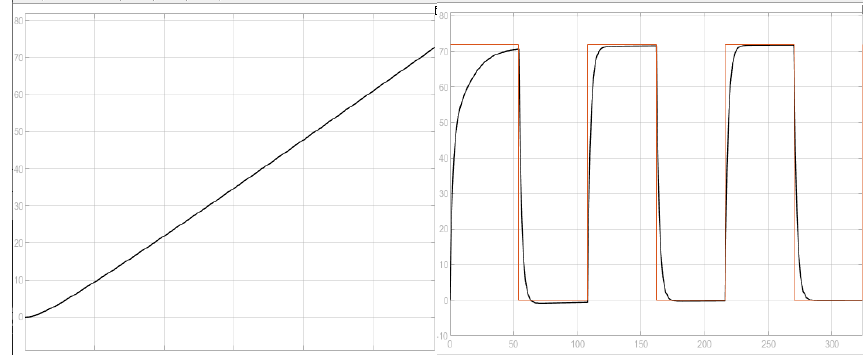
Figure 23. Response of the cutting process to a ramp input and a pulse generator n = 4.